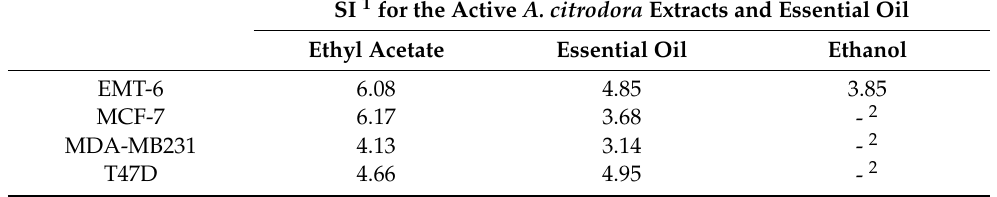
Table 6. The selectivity index for A. citrodora extracts and essential oil. SI = IC 50 of the normal cell line (Vero)/IC 50 of each extract.